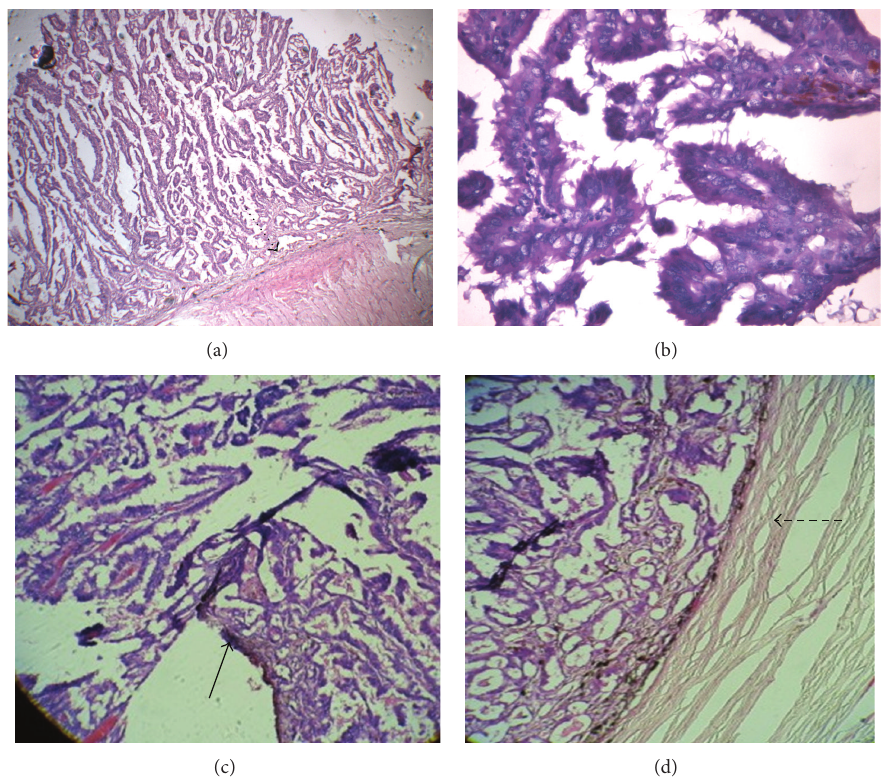
Figure 2: Histopathological photomicrograph (H & E stain) showing (a) low magnification (4x) intraocular tumor at posterior pole of the globe arising from the RPE sitting over the optic nerve head (dotted arrow) and infiltrating into the choroid. (a) High magnification (40x) typical papillary pattern with round to oval cells with vesicular nuclei suggestive of adenocarcinoma. Focal areas showing pigmentation are seen. (c) Tumor seen breaking through the RPE (arrow) and infiltrating the choroid. (d) Tumor arising from the RPE and involving the optic nerve (dashed